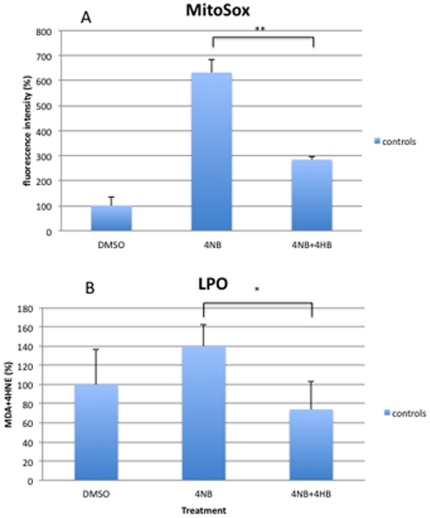
Quantitation of MitoSox staining by flow cytometry (panel A) and oxidation of lipids (panel B) in control skin fibroblasts (n = 5) after co-treatment with 4 mM 4-NB+2 mM 4-HB.The values are expressed as percentage of the control skin fibroblasts after 4 mM DMSO (** P<0.01).